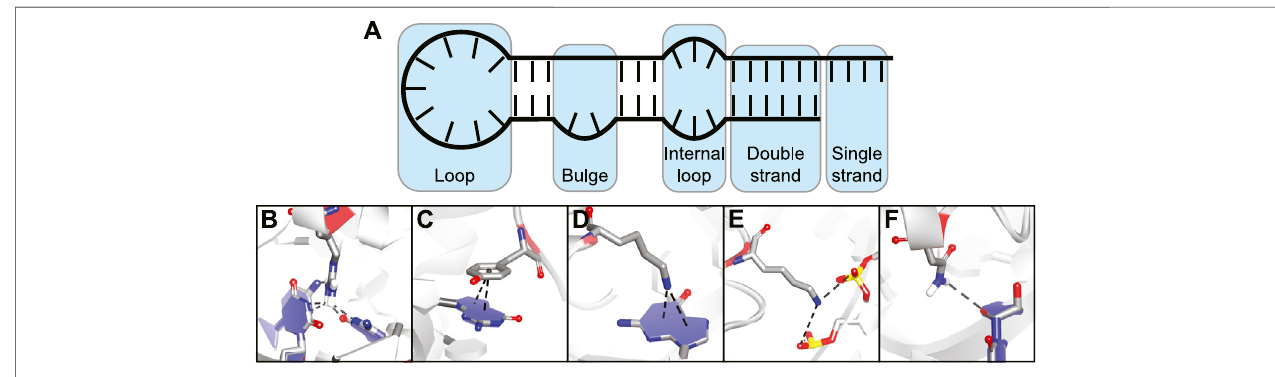
FIGURE 2 | (A) Different secondary structural elements of RNA. (B) Hydrogen bonding interaction between amino acid and nucleotide base. (C) Stacking interaction between amino acid and nucleotide base. (D) Cation- π interaction between charged amino acid and nucleotide base. (E) Electrostatic interaction between charged amino acid and backbone phosphates. (F) Hydrogen bonding interaction between amino acid and nucleotide ribose.